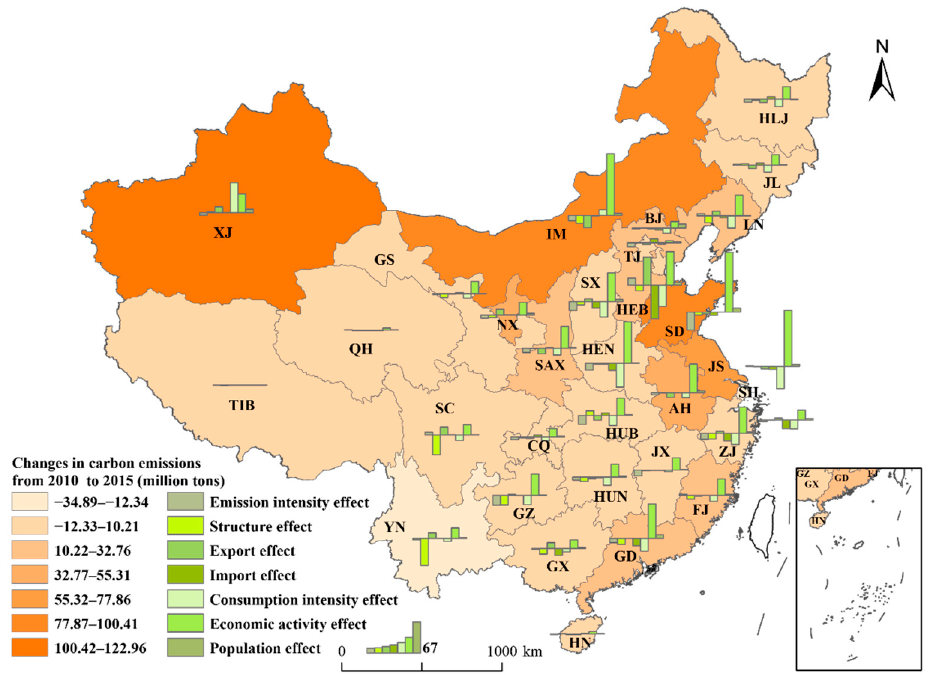
Figure 8. Provincial changes in carbon emissions and driving forces during 2010–2015.